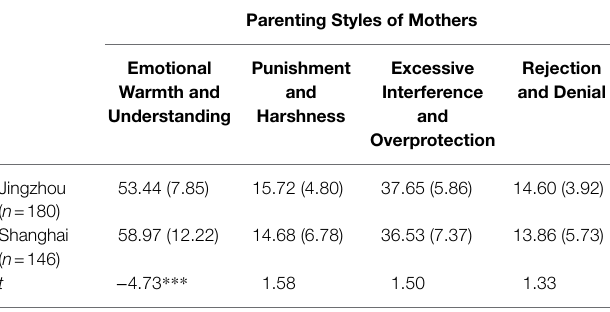
TABLE 3 | Comparison of differences in the parenting styles of mothers of primary school students in different regions M